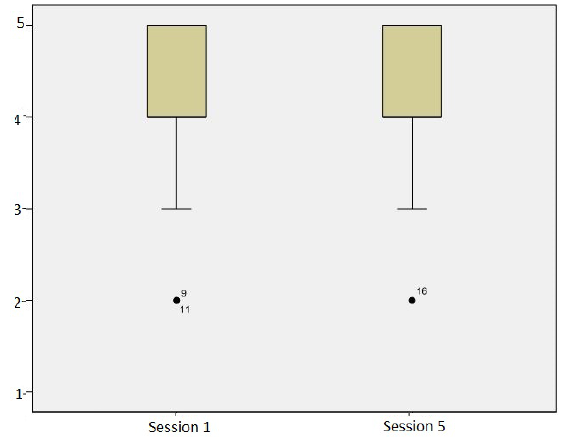
Figure 13. User’s experience of collaboration with AIBO in the system for AIBO mode (data extracted from questionnaires).